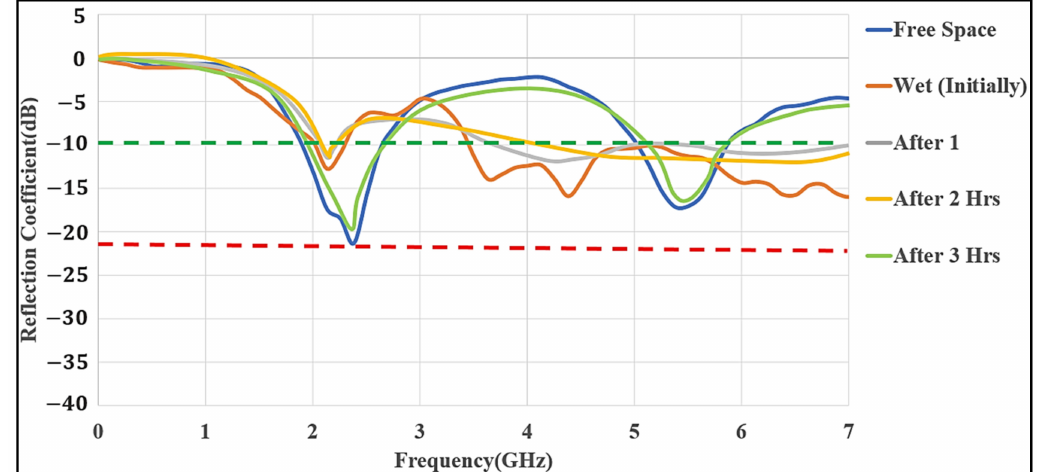
Figure 8. Measured S 11 of the MMAs in wet conditions (Ref (free-space), initial condition, after 1 h, 2 h, and 3